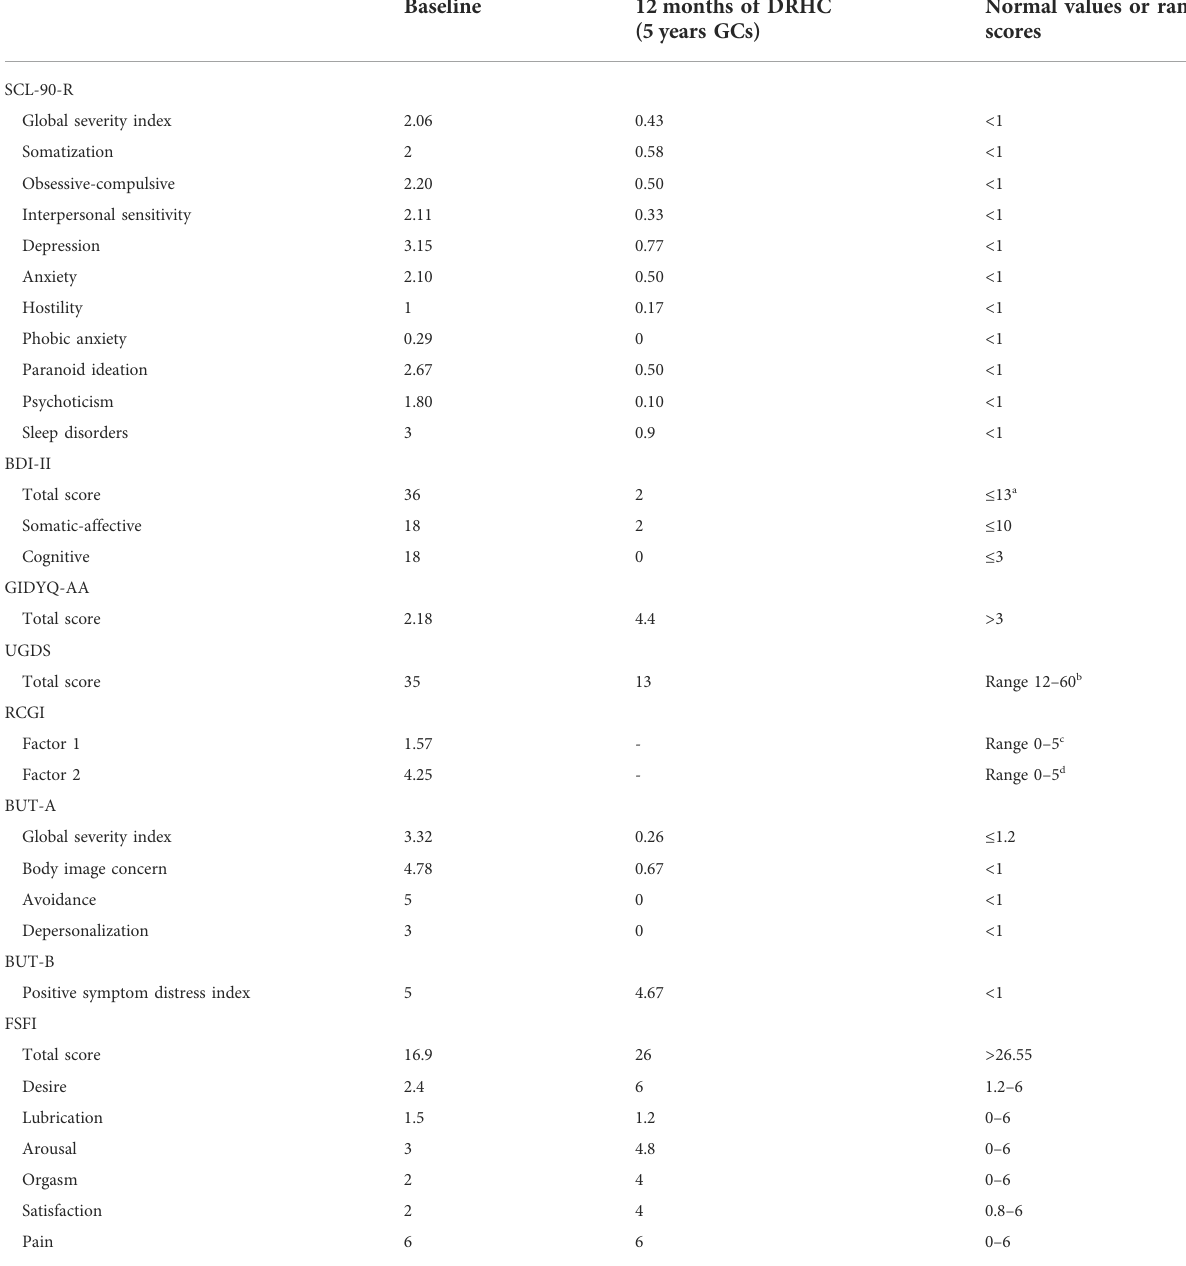
TABLE 2 Psychological, sexual, and gender assessment at diagnosis and after 12 months of dual-release hydrocortisone treatment (5 years of GCs). Baseline 12 months of DRHC Normal values or range (5 years GCs)